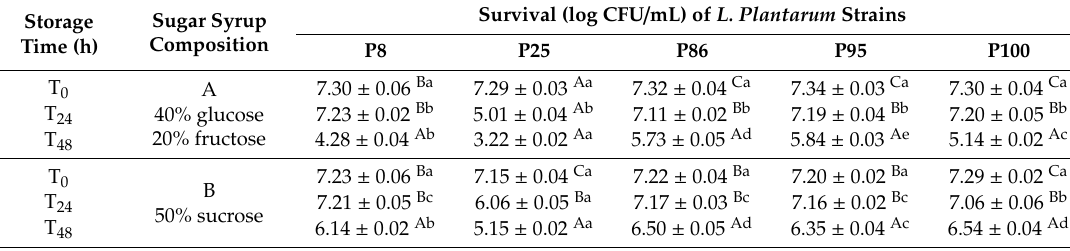
Table 4. Survival of the L. plantarum strains in sugar syrups stored for 24-48 h at 20 ◦ C. Test A: